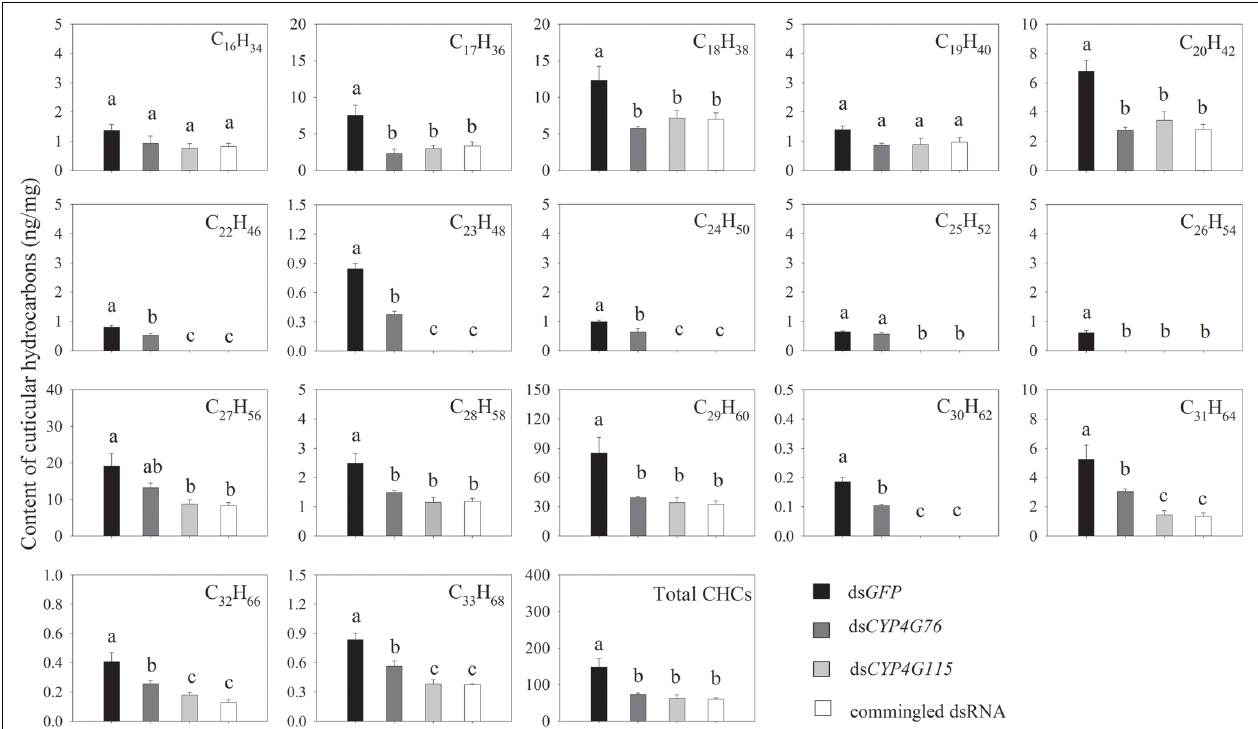
FIGURE 5 | CHCs content measured from the external surface of Nilaparvata lugens nymphs. Commingled dsRNA contained CYP4G76 and CYP4G115 (1:1). Mean ± SE was calculated from three biological replicates, and each biological replicate contained fifty fourth instar N. lugens nymphs. Different lowercase letters in each figure showed the significant difference (ANOVA, LSD, p < 0.05).